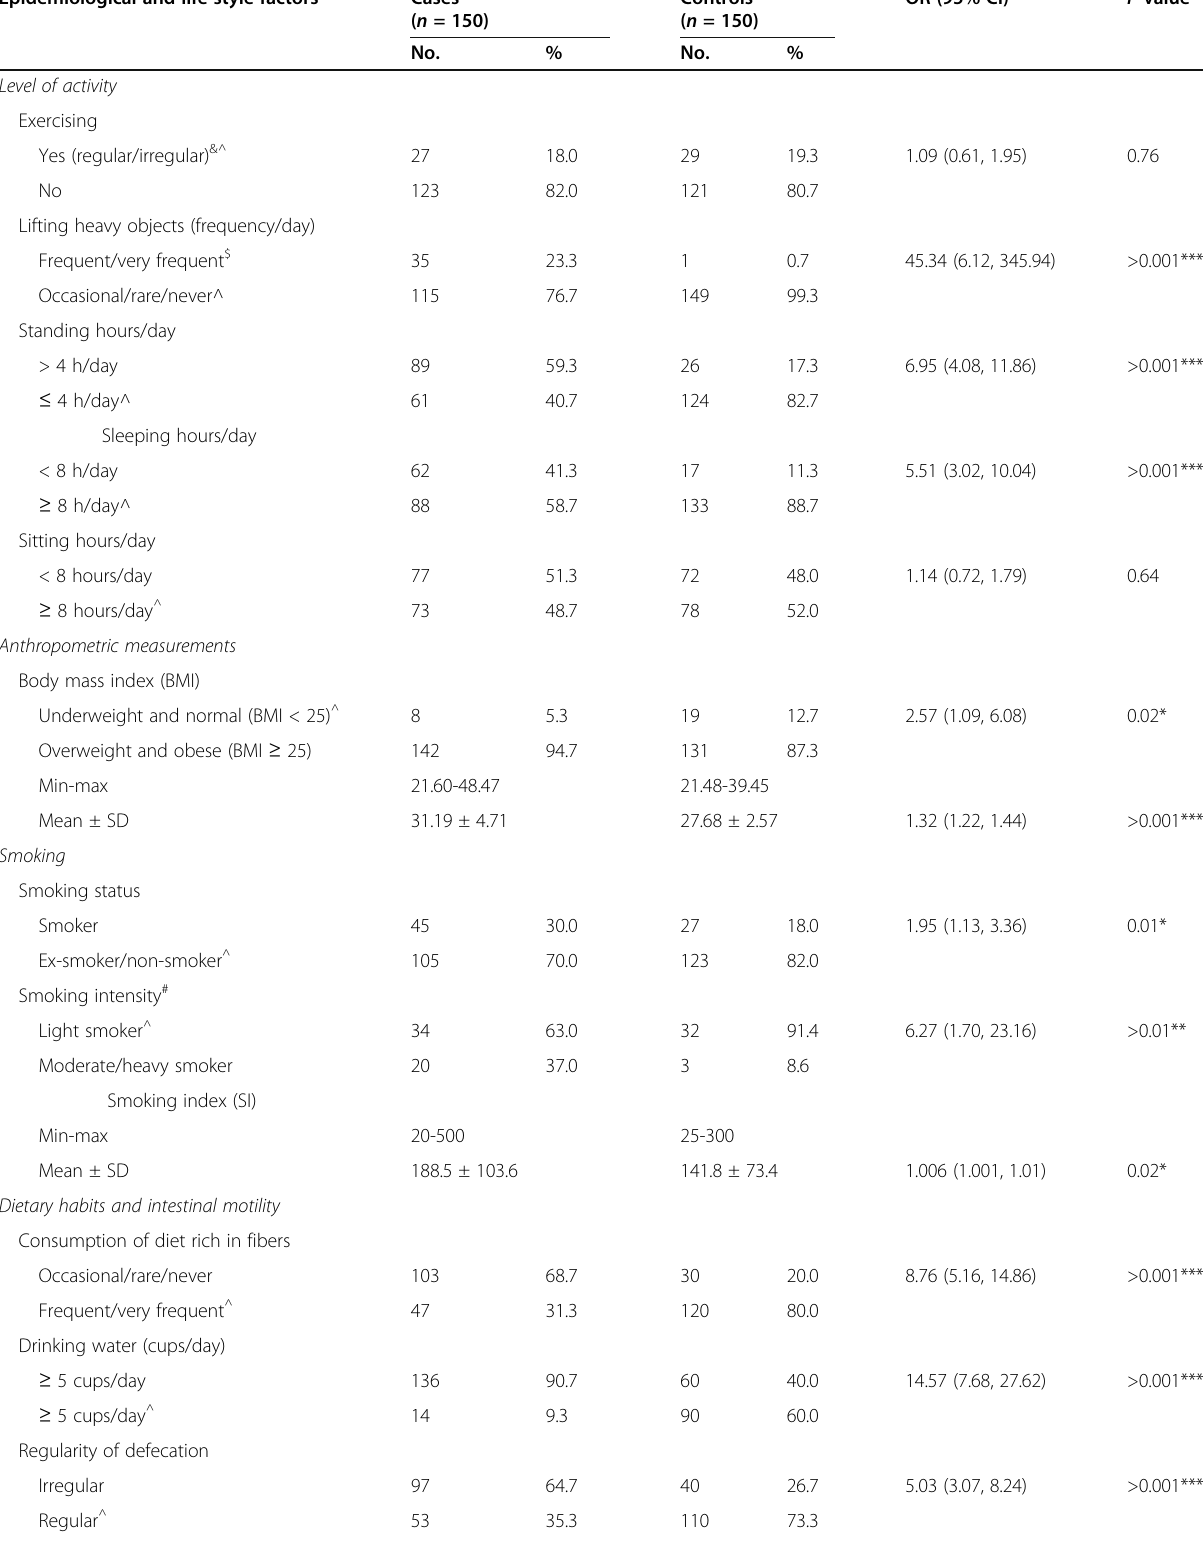
Table 2 Epidemiological and life style factors associated with lower limbs varicose veins (LLVV) Epidemiological and life style